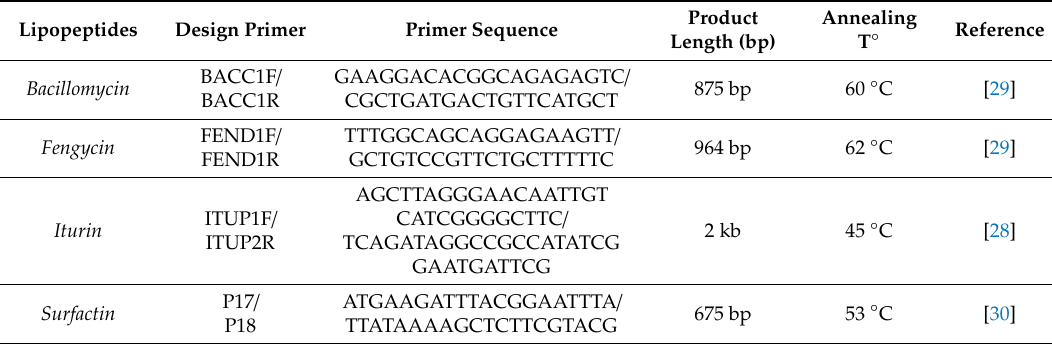
Table 2. List of specific primers used in this